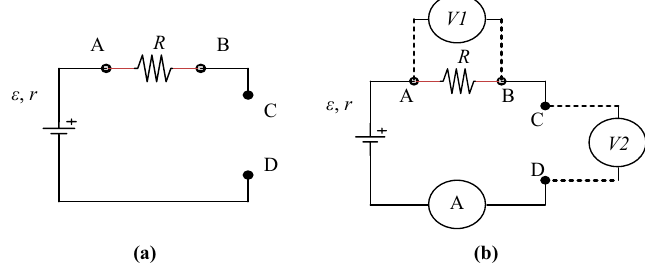
Fig. 10. The potential difference and the electromotive